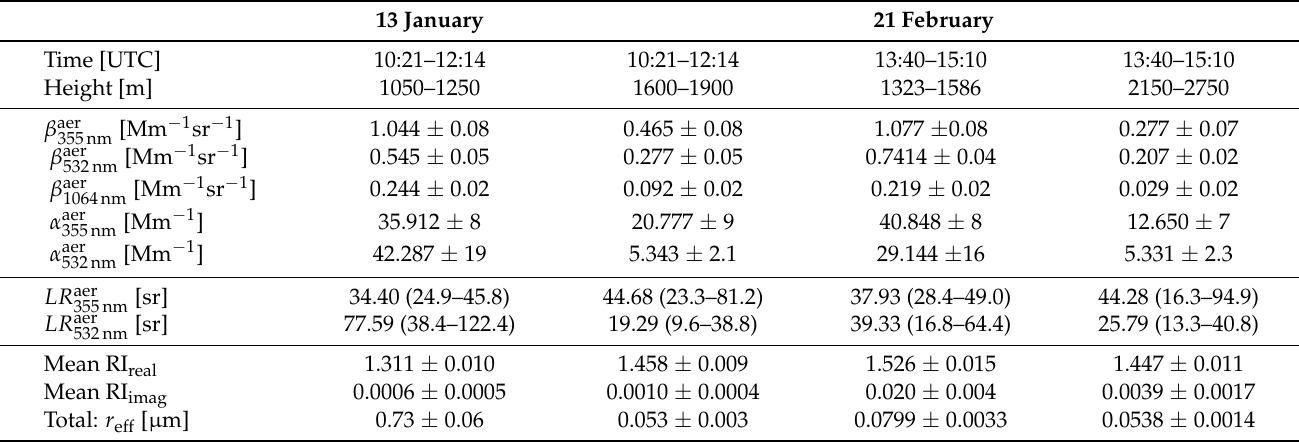
Figure 4. Five-day backward trajectories calculated with HYSPLIT [31,32]. The initial position is the location of the lidar in Ny-Ålesund at the altitude of the sampled aerosol layer. The position of RV Polarstern at 12 January, 2020, 06:00UTC is also marked [33]. Table 3. Optical and microphysical parameters for the different layers. The first mode is always the mode with the smaller radius r mod . For the optical parameters, the largest possible uncertainty according to the maximum error estimate is